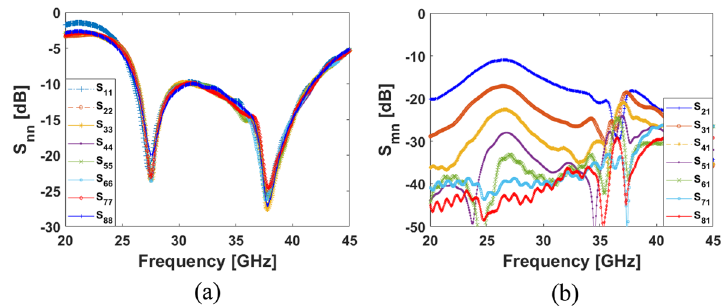
Figure 26. ( a ) S nn (S 11 –S 88 ) and ( b ) S mn (S 21 –S 81 ) results of the suggested phased array.